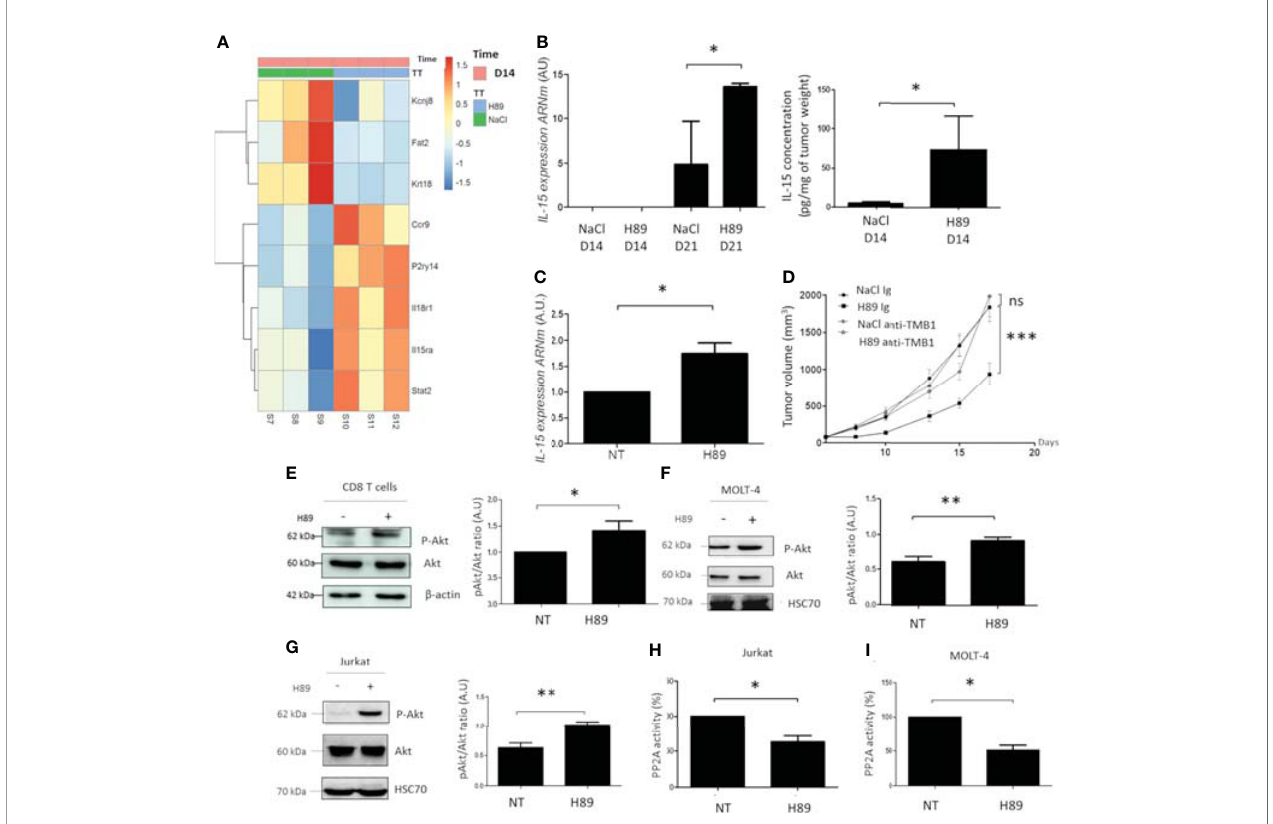
FIGURE 6 | H89 regulates signaling pathways involved in immune cell activation and cancer cell growth. (A) RNAseq analysis were performed on CT26 solid tumors isolated from BALB/c mice treated or not (NaCl) with H89 (10 mg/kg, i.p.) at D14 after colon cancer cells injection ( n = 3 mice/group). (B) RT-qPCR analysis of IL-15 expression mRNA level at D14 and D21 after CT26 cancer cell injection into BALB/c mice ( n = 3 mice/group) and ELISA analysis of IL-15 on tumor lysates ad D14 ( n = 5 mice/group). (C) RT-qPCR analysis of IL-15 expression mRNA level on CT26 cells treated in vitro with H89 for 24 h ( n = 3). (D) CT26 tumor-bearing BALB/c mice (5 × 10 5 CT26 cells in s.c.) were treated, or not (NaCl, i.p.), with H89 (10 mg/kg, i.p.) twice a week. Mice also received anti-TMB1 or control IgG injections once a week (50 µg in i.p.), and tumor growth was monitored three times a week ( n = 7 mice/group). (E – G) Western blot analysis of Akt phosphorylation (P-Akt) after H89 treatment in CD8 T cells isolated from the spleen of BALB/c mice or MOLT-4 and Jurkat T cells ( n = 5) (H, I) Quanti fi cation of the enzymatic activity of phosphatase PP2A in Jurkat and MOLT-4 T cells ( n = 3). Statistically signi fi cant differences were determined by using two-way ANOVA (D) or a t -test (B , C , E – I) : * p ≤ 0.05 (or 0.1 in (B) with 90% con fi dence level); ** p ≤ 0.01; *** p ≤ 0.001; n.s., nonsigni fi cant results. RNAseq analysis was performed with the DESeq2 package using a Wald